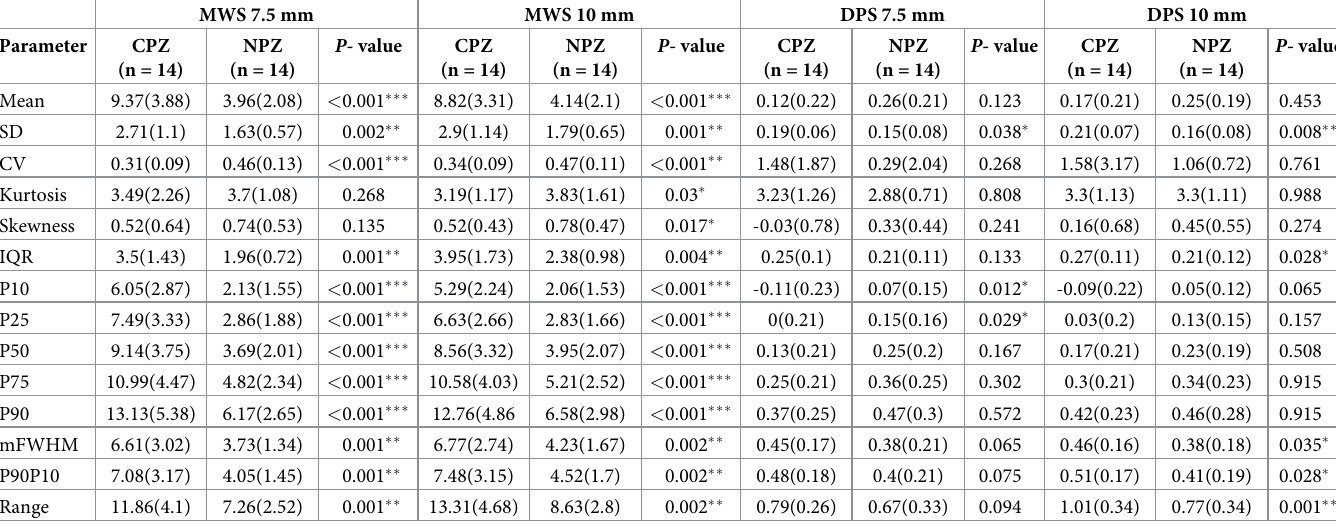
Table 3. Differences in the MWS and DPS histogram parameters between CPZ and NPZ with different diameters of the ROI.